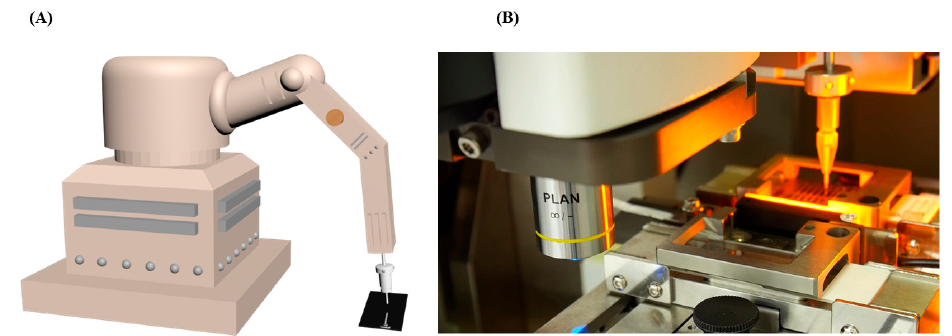
Figure 3. An automated cell picker. ( A ) A schematic diagram of the cell picker machine. ( B ) The targeted cell enriched on the Coral Chip can be automatically recovered by the cell picker.